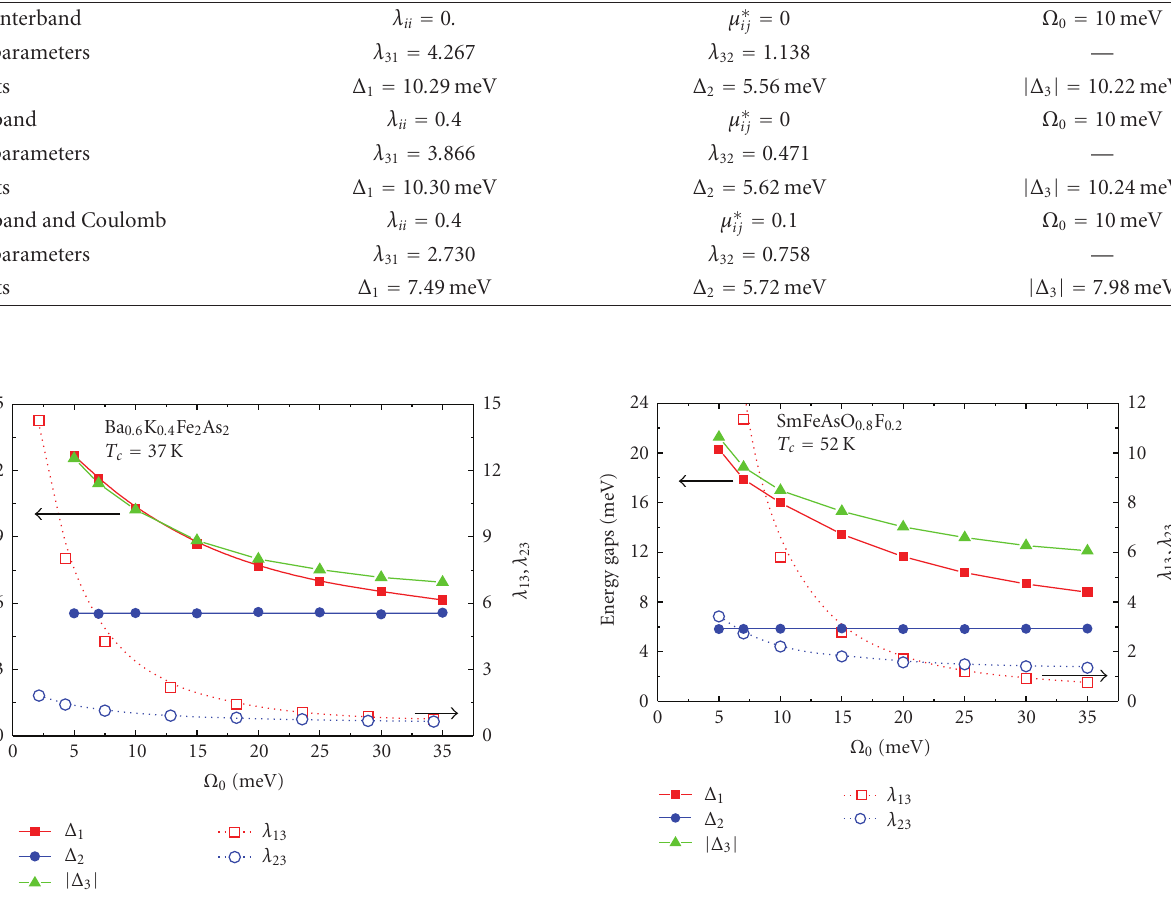
Figure 4: Full symbols, left axis: calculated gap values at T = 2 K for SmFeAsO 0 . 8 F 0 . 2 as a function of the typical boson energy Ω 0 . Open symbols, right axis: electron-boson coupling constants, λ 13 and λ 23 , as a function of Ω 0